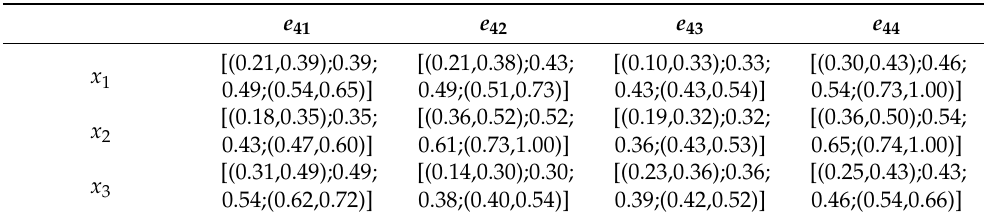
Table A17. The influencing factors of B 4 in the whole time period belong to the comprehensive evaluation value of different risks.